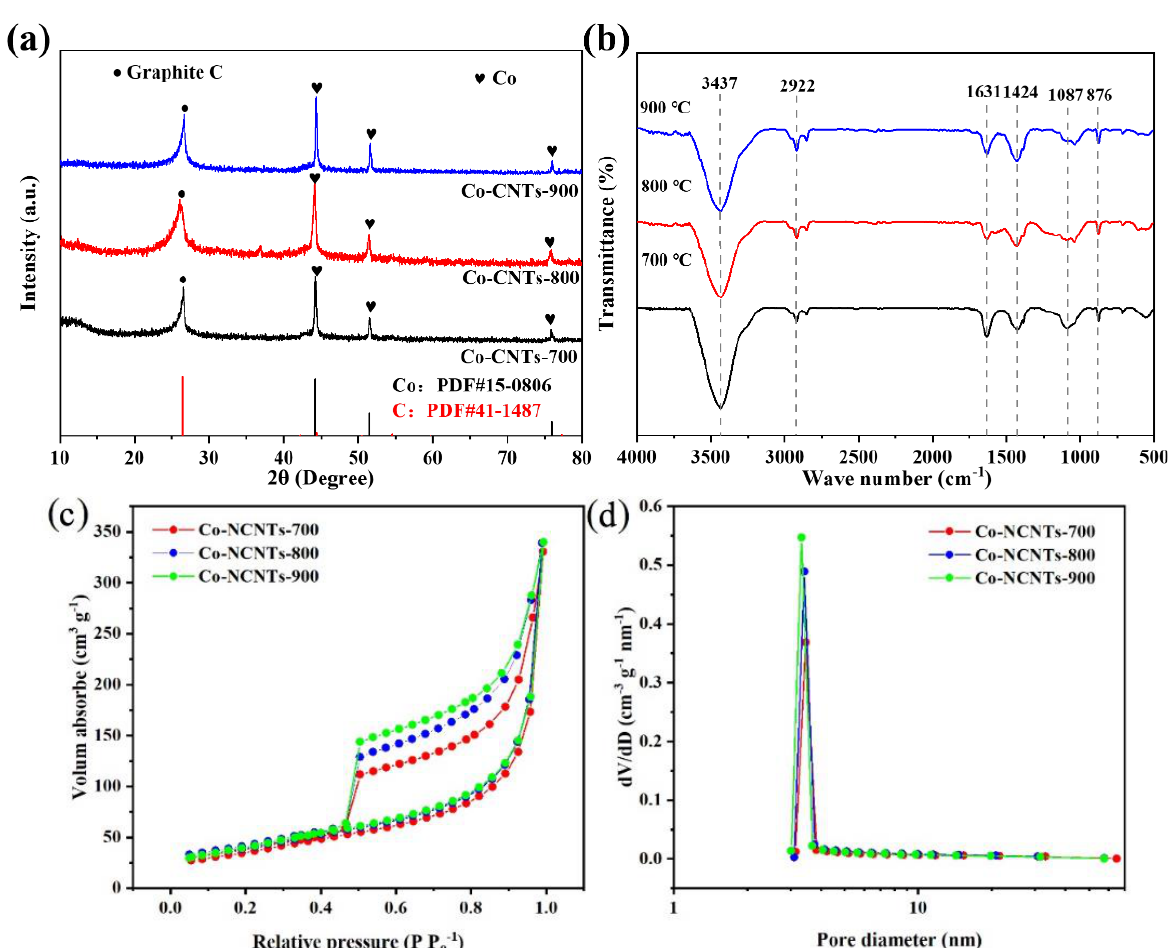
Figure 2. ( a ) XRD, ( b ) FTIR, ( c ) N 2 adsorption–desorption isotherms and ( d ) pore size distribution patterns of Co−N−CNTs synthesized at different temperature.